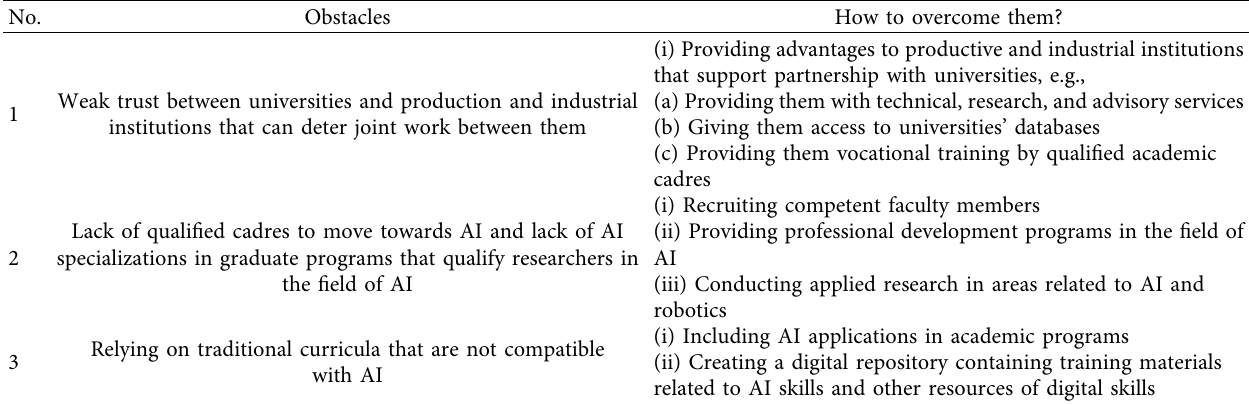
Table 14: Obstacles of implementing the proposal and how to overcome